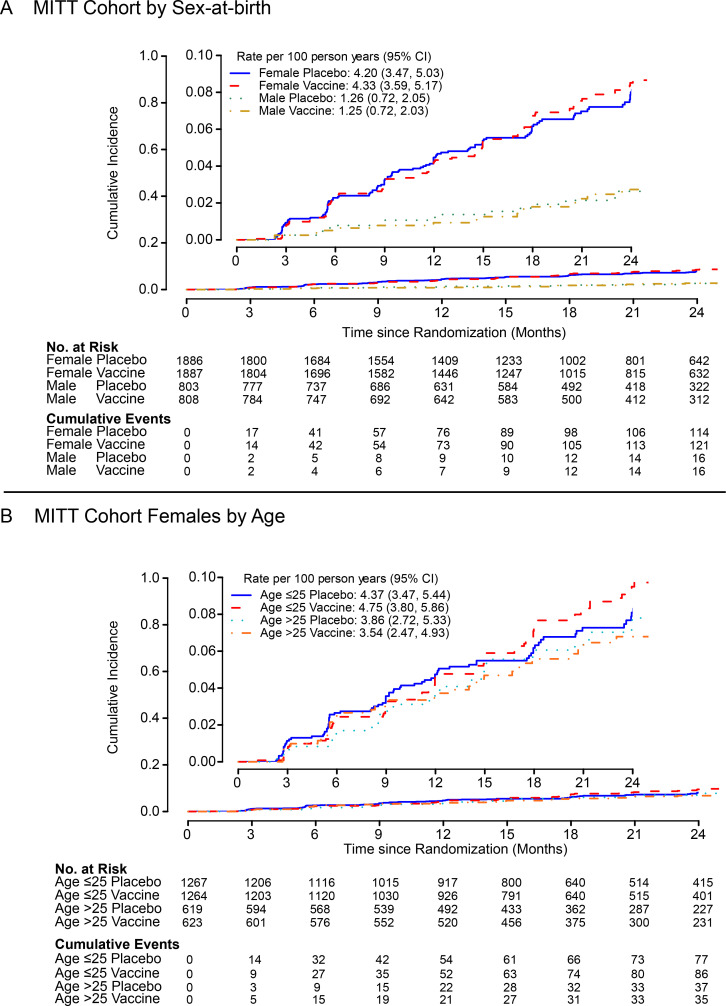
Cumulative incidence of HIV-1 infection by pre-specified
baseline variables. Cumulative incidence over months 0-24
in the MITT cohort, by sex-at-birth (A) and by age among females
(B). Inset shows the same data on an expanded axis.